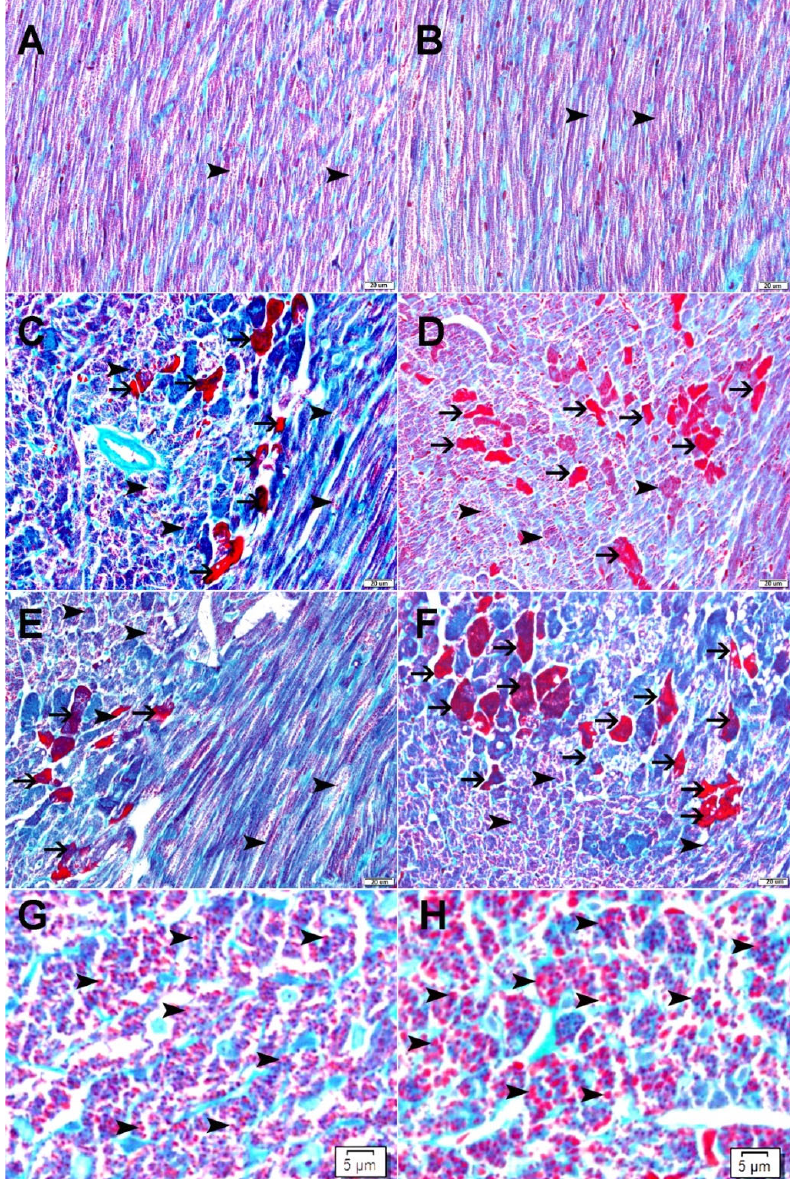
Figure 6. ( A ) Representative sections from the left ventricle of Gal ‐ 3 wild type saline ‐ treated mice showing normal distribution of normal, red ‐ stained mitochondria (arrowhead) inside cardiomyocytes. ( B ) Representative sections from the left ventricle of Gal ‐ 3 KO saline ‐ treated mice showing normal distribution of normal, red ‐ stained mitochondria (arrowhead) inside cardiomyocytes. ( C ) Representative sections from the left ventricle of Gal ‐ 3 wild type DOXO ‐ treated mice showing enlarged, red ‐ stained mitochondria (arrowhead) inside cardiomyocytes with focal severely injured cardiomyocytes (thin arrow). ( D ) Representative sections from the left ventricle of Gal ‐ 3 KO DOXO ‐ treated mice showing enlarged, red ‐ stained mitochondria (arrowhead) inside cardiomyocytes with a higher number of severely injured cardiomyocytes (thin arrow). ( E ) Representative sections from the left ventricle of Gal ‐ 3 wild type DOXO ‐ treated mice showing enlarged, red ‐ stained mitochondria (arrowhead) inside cardiomyocytes with focal severely injured cardiomyocytes (thin arrow). ( F ) Representative sections from the left ventricle of Gal ‐ 3 KO DOXO ‐ treated mice showing enlarged, red ‐ stained mitochondria (arrowhead) inside cardiomyocytes with a higher number of severely injured cardiomyocytes (thin arrow). ( G ) A high power magnification of representative sections from the left ventricle of Gal ‐ 3 wild type DOXO ‐ treated mice showing enlarged, red ‐ stained mitochondria (arrowhead) inside cardiomyocytes.